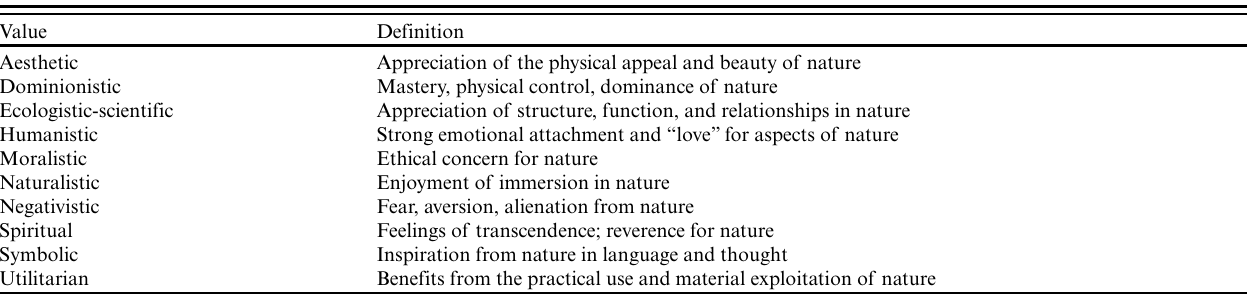
Table 1 . Kellert’s nature-related values typology (Kellert 1996,